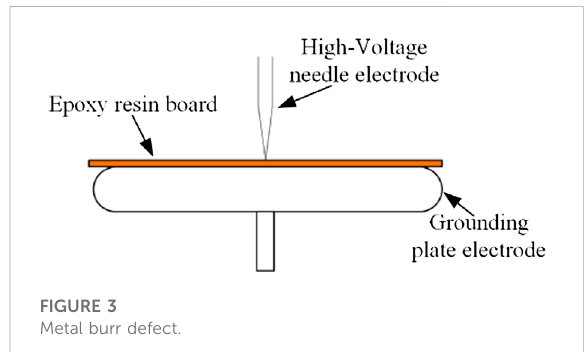
FIGURE 4 Pollution defect.